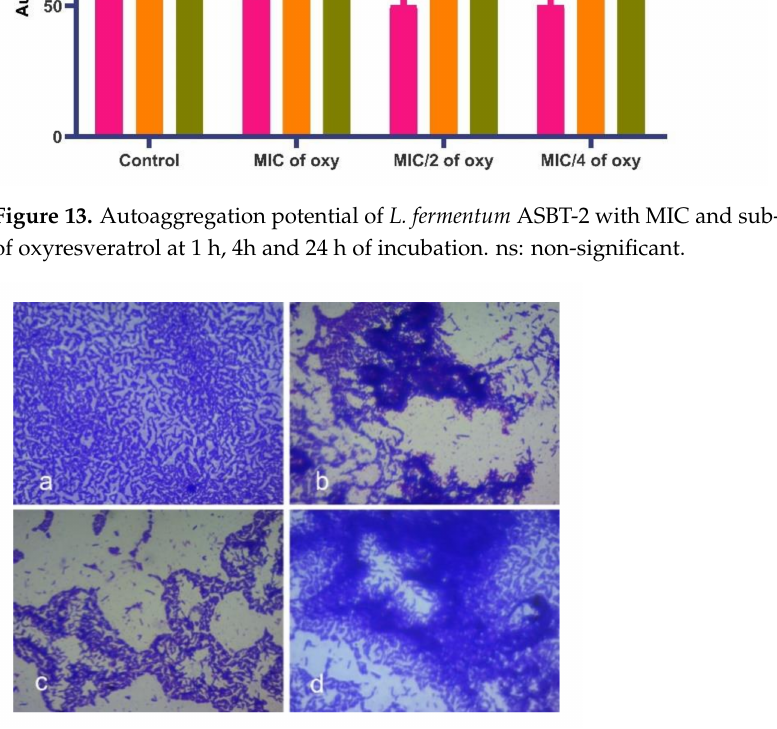
Figure 14. Microscopic images (crystal violet stained) of L. fermentum ASBT-2 demonstrating autoag- gregation when treated with different concentrations of oxyresveratrol after 24 h (100 × magnification). ( a ) Control without oxyresveratrol; ( b ) cells treated with MIC of oxyresveratrol; ( c ) cells treated with MIC/2 of oxyresveratrol; ( d ) cells treated with MIC/4 of